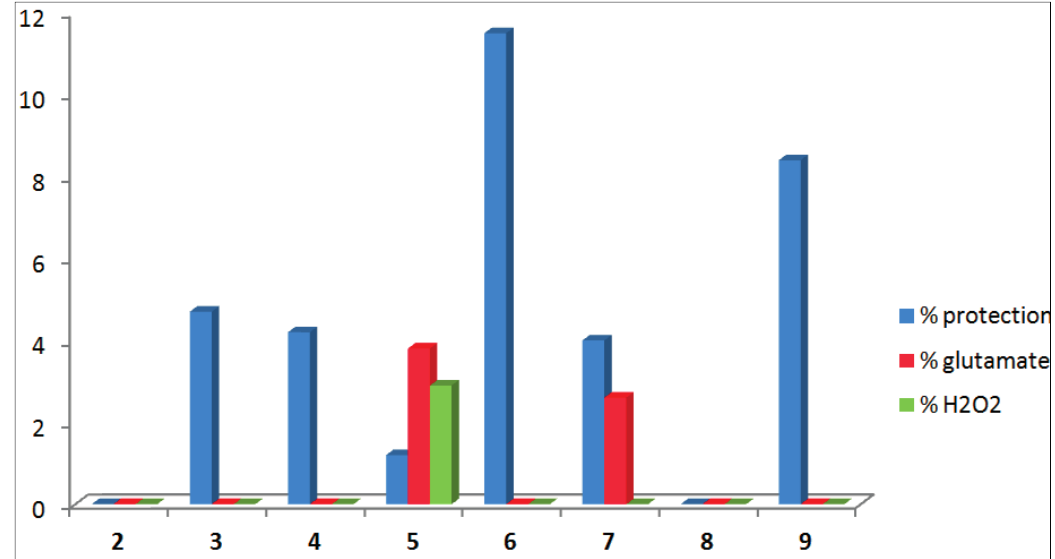
Figure 3. Results of the experimental assay of neuroprotective effect of the new compounds.